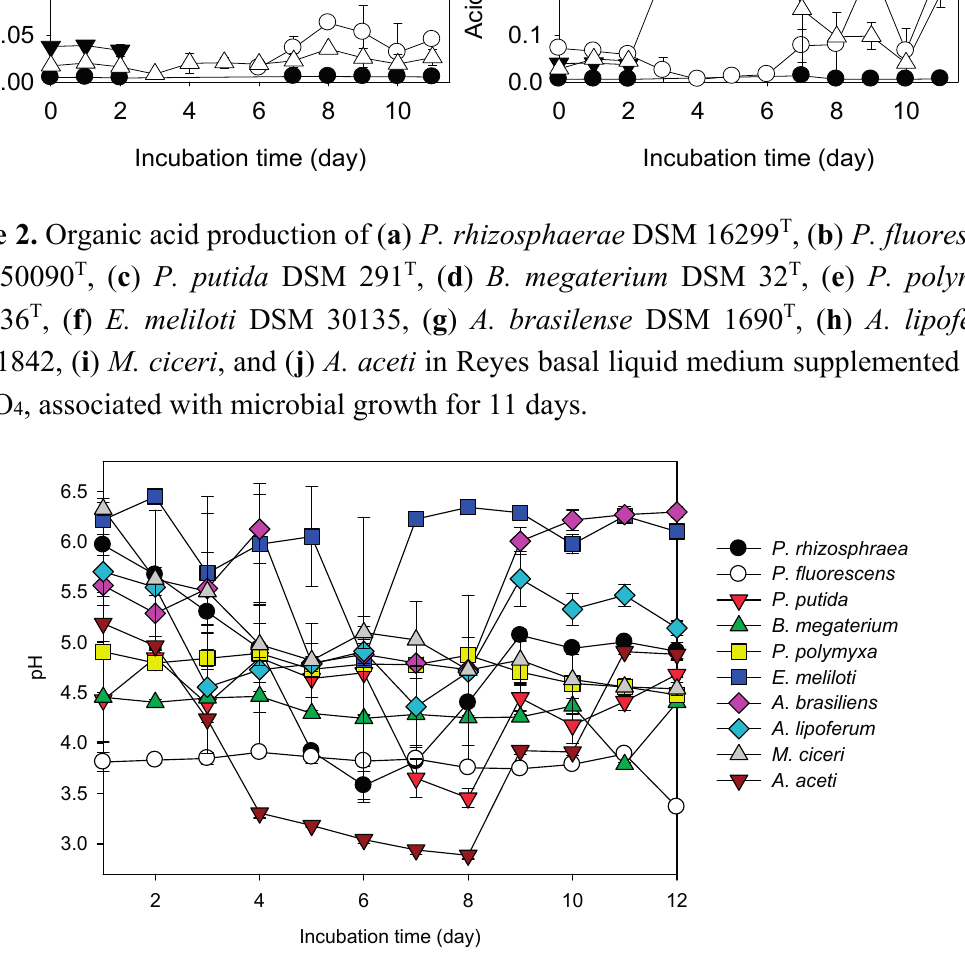
Figure 3. The pH changes induced by phosphate solubilizing bacteria (PSB) during incubation in Reyes minimal medium supplemented with K 2 HPO 4